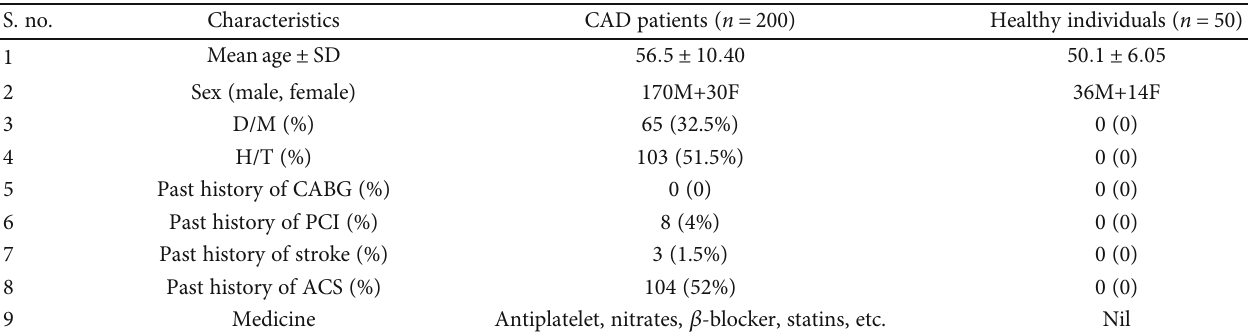
Table 1: Demography clinical assessment of CAD patients and healthy individuals. CAD: coronary artery disease; D/M: diabetes mellitus; H/T: hypertension; CABG: coronary artery bypass grafting; ACS: acute coronary syndrome; PCI: percutaneous coronary intervention. S.